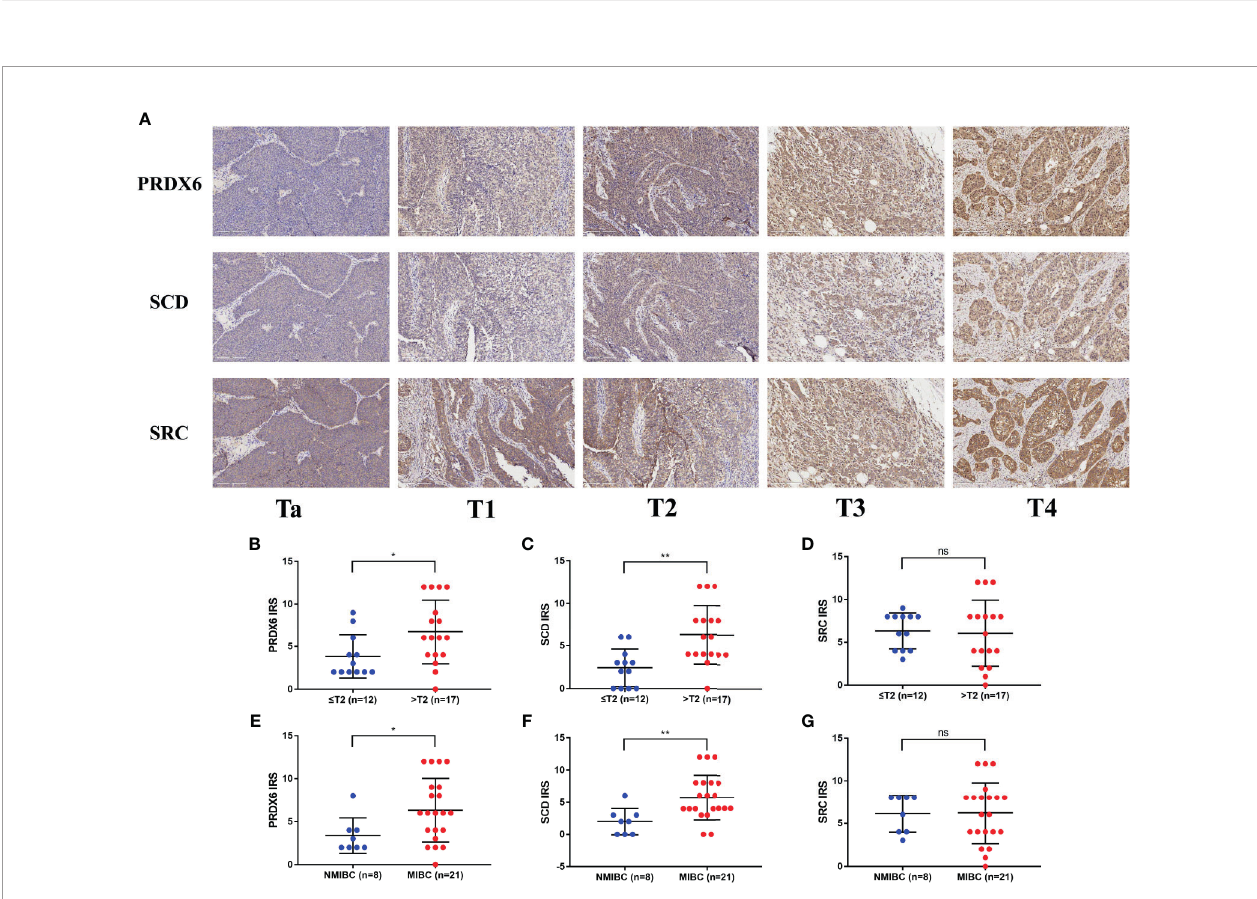
FIGURE 9 | Immunohistochemistry results of three key FRGs. (A) Representative immunohistochemistry images of PRDX6, SCD, and SRC in different T stage of BLCA. Comparisons of IRS of PRDX6 (B, E) , SCD (C, F) , and SRC (D, G) between NMIBC and MIBC or in different T stage of BLCA. *p < 0.05, **p < 0.01, ns means no signi fi cant difference. FRG, ferroptosis − related gene; BLCA, bladder cancer; IRS, immunoreactive score; NMIBC, non-muscle invasive bladder cancer; MIBC, muscle-invasive bladder